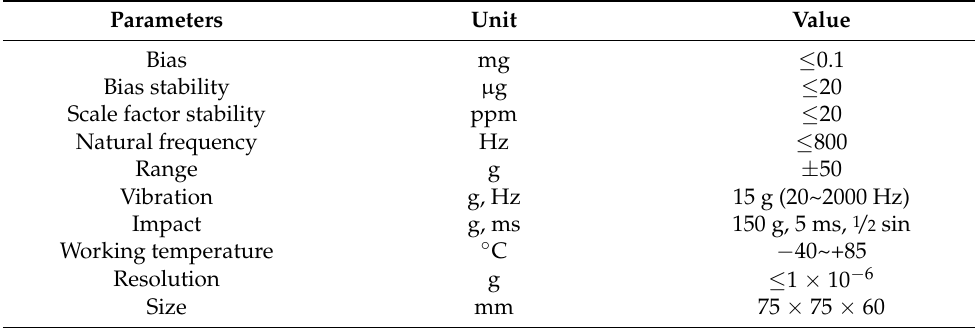
Figure 4. Schematic diagram of casing vibration transmission test. Table 1. The acceleration sensor